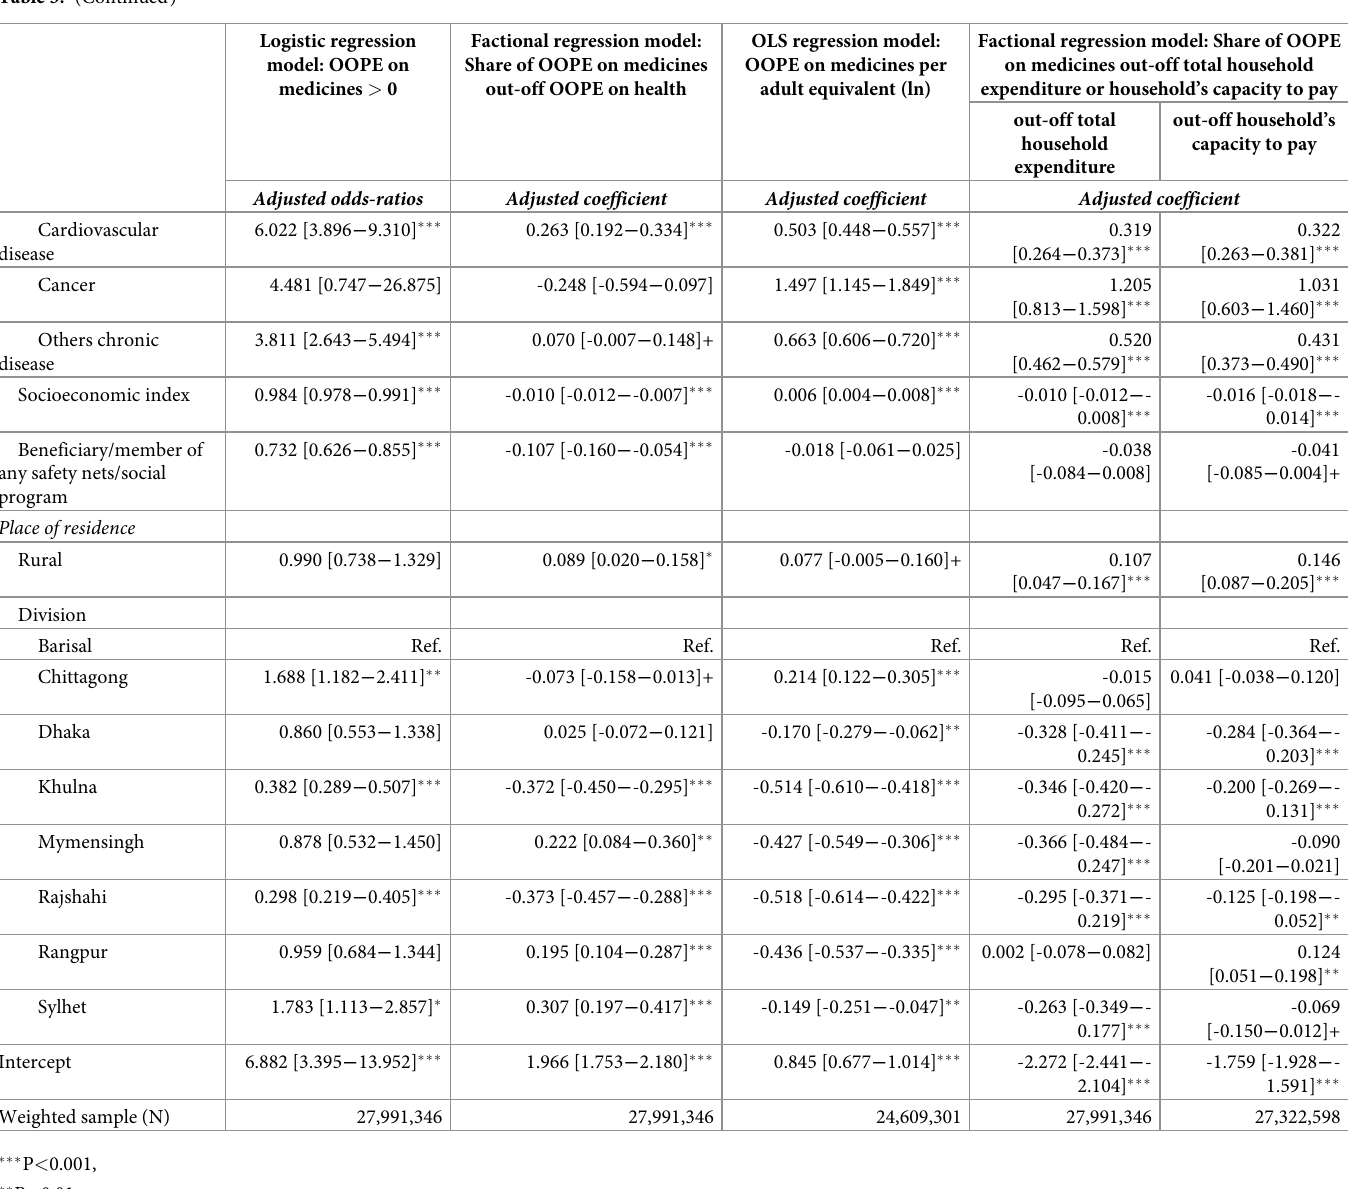
Twenty six percent of households spend more than 10% of their OOPE on medicines. By increasing the spending threshold to 15% of OOPE, the percentage of households incurring this level of spending dropped to 6.8% (Table 4). Nearly two percent (1.8%) of households spent 20%, and 0.1% spent 30% of their total expenditure on OOPE for medicines. These pro- portions decrease with increasing wealth. For instance, 27.3% of households in the 1 st quintile spent 10% of their household expenditure on medicines compared to 23.6% in the 5 th